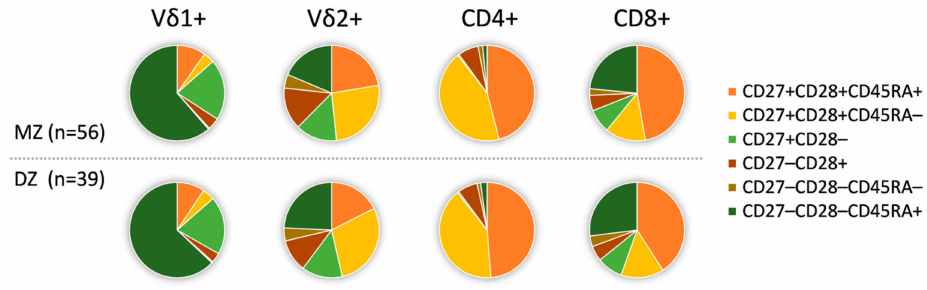
Figure 3. Similar differentiation status of T cell subsets in monozygotic and dizygotic twins. The distribution of differentia- tion phenotypes varied between V δ 1+, V δ 2+, CD4+ and CD8+ T cells, but was comparable between the groups of MZ and DZ twins. Pie charts represent the mean of each differentiation phenotype in the sub-groups of MZ and DZ twins.